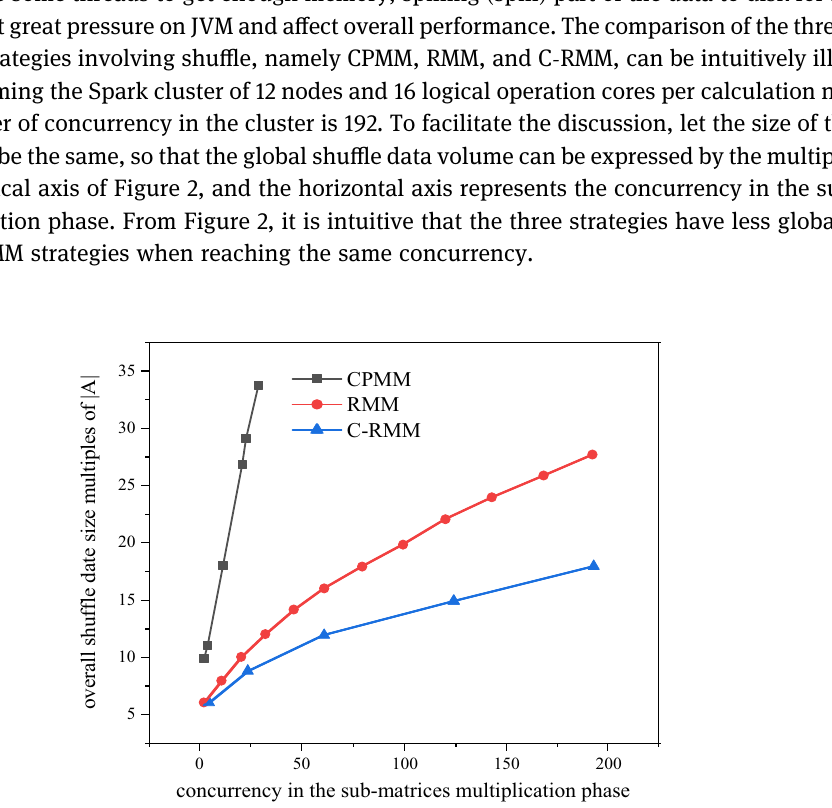
Figure 2: The shu ffl e data volume of the three multiplication execution strategies, vs An intuitive comparison of the concurrency ( 192 logos in the cluster Q )